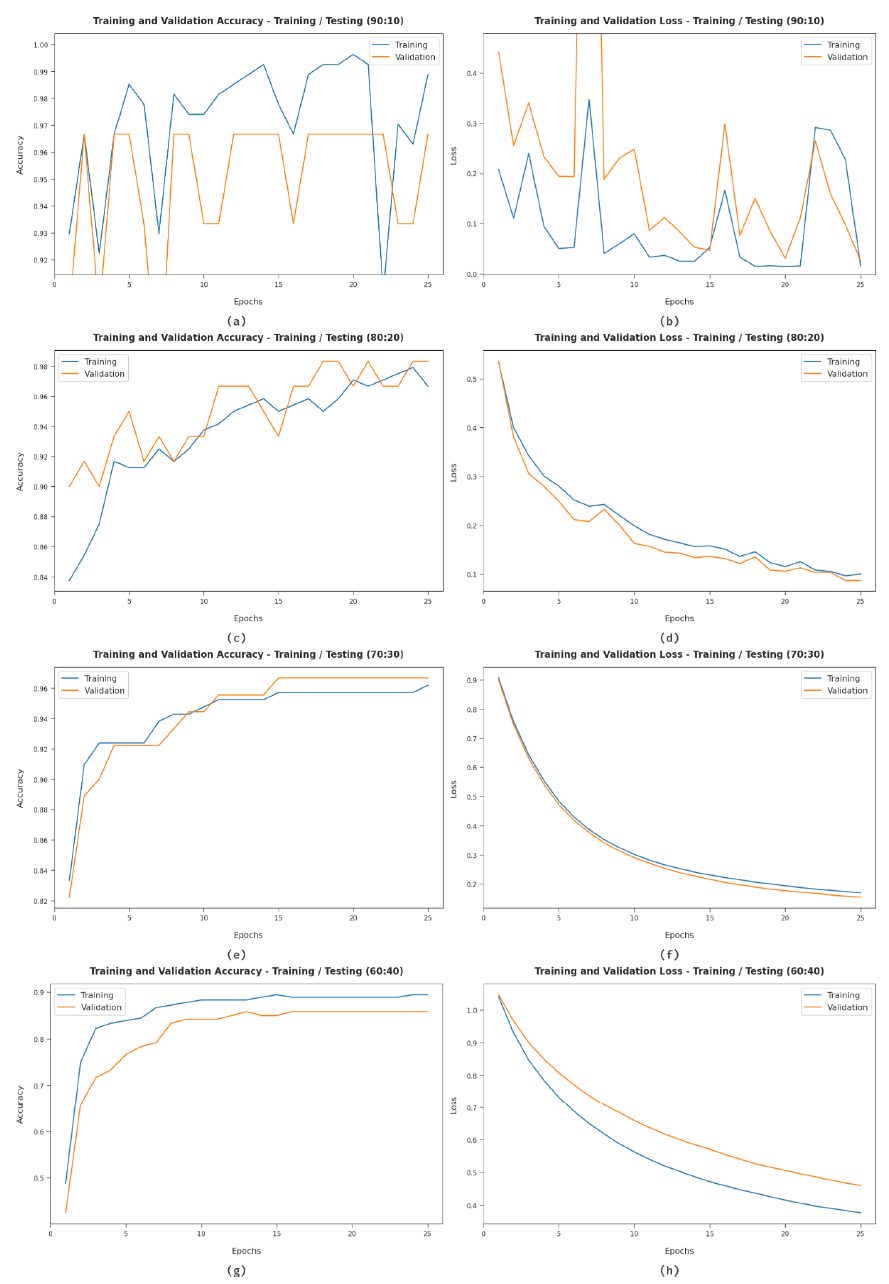
Figure 6. Accuracy and loss analyses results of the CSO-CADLCC technique under distinct TR/TS data. ( a ) TA/VA data of 90:10, ( b ) TL/VL data of 90:10, ( c ) TA/VA data of 80:20, ( d ) TL/VL data of 80:20, ( e ) TA/VA data of 70:30, ( f ) TL/VL data of 70:30, ( g ) TA/VA data of 60:40, ( h ) TL/VL data of